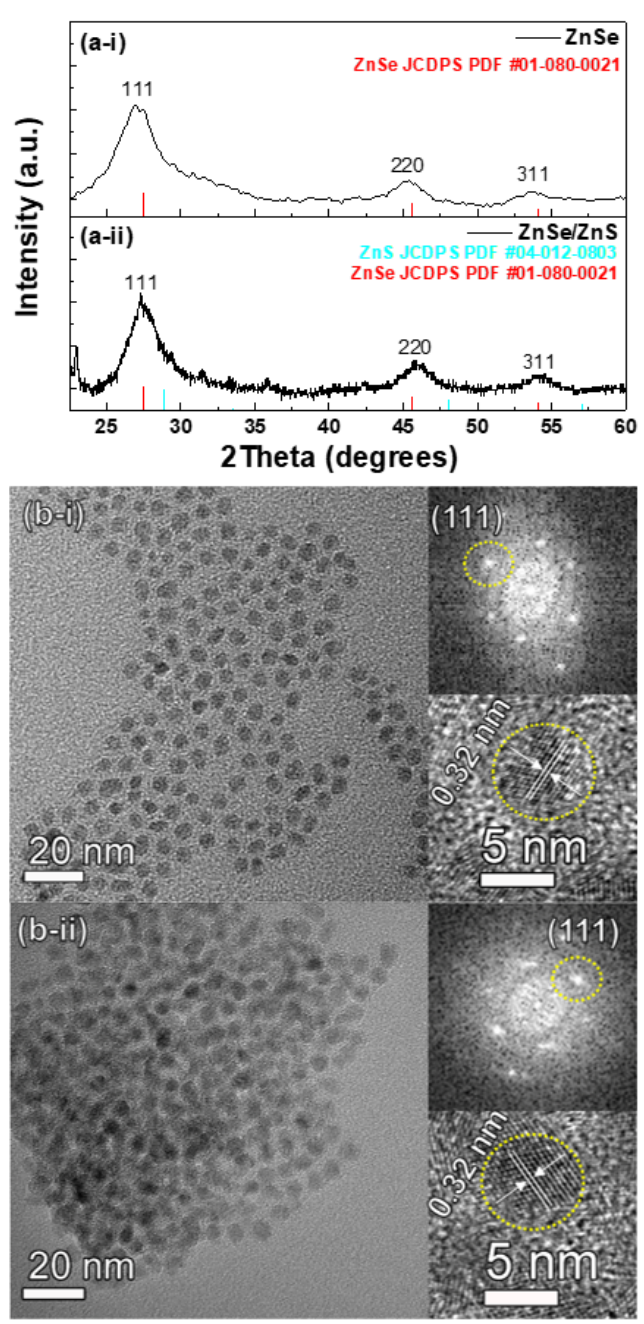
Figure 4. ( a ) XRD patterns and ( b ) TEM images of ( i ) ZnSe C QDs and ( ii ) ZnSe/ZnS C/S QDs. Lower insets in ( b ) show HR-TEM images of ( i ) ZnSe C QDs and ( ii ) ZnSe/ZnS C/S QDs and the upper insets in ( b ) show FFT patterns for the corresponding HR-TEM images. nUV LED-pumped blue LEDs were fabricated with the ZnSe/ZnS C/S QDs. Figure 5 shows the optical properties of the fabricated blue LEDs, which were evaluated at 60 mA. In the EL spectrum, two peaks were observed. One peak in the nUV region and the other peak in the blue region were attributed to the nUV LED and ZnSe/ZnS C/S QDs, respectively. Blue light was emitted from the fabricated LED due to the strong EL peak in the